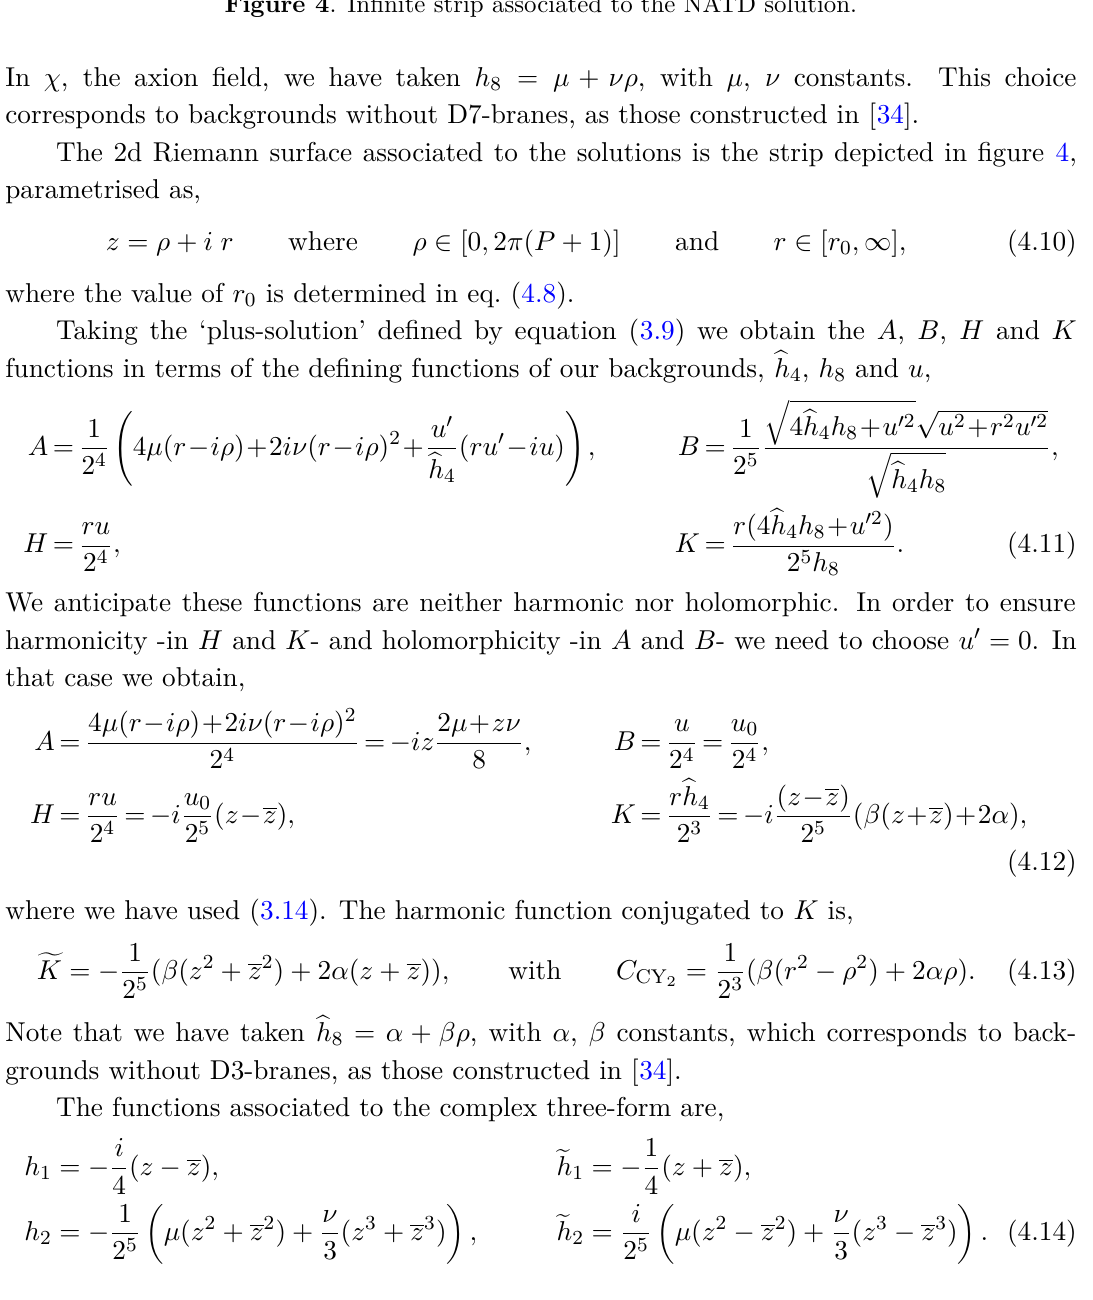
Figure 4 . Infinite strip associated to the NATD